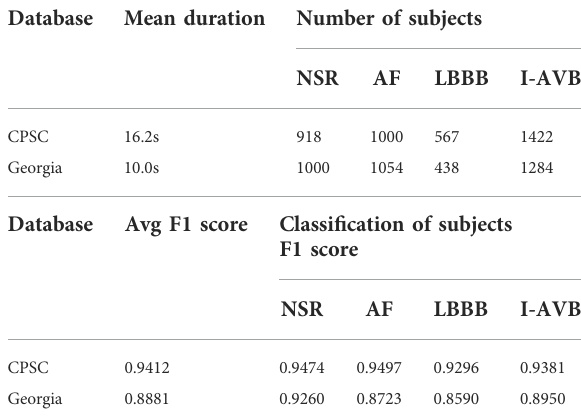
TABLE 9 Generalization ability of the proposed method for CA classi fi cation on extra datasets.